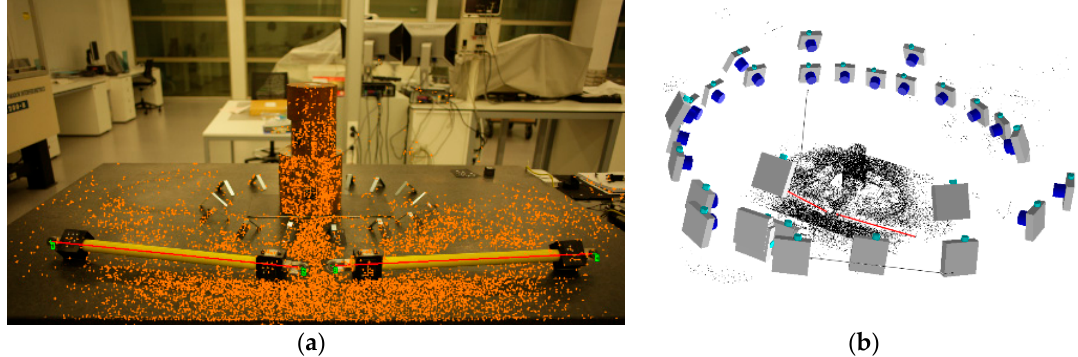
Figure 9. Targetless orientation in lab: ( a ) tie point image identification (in orange) and length bar definition (in red); and ( b ) sparse triangulation of feature points and camera network determination.